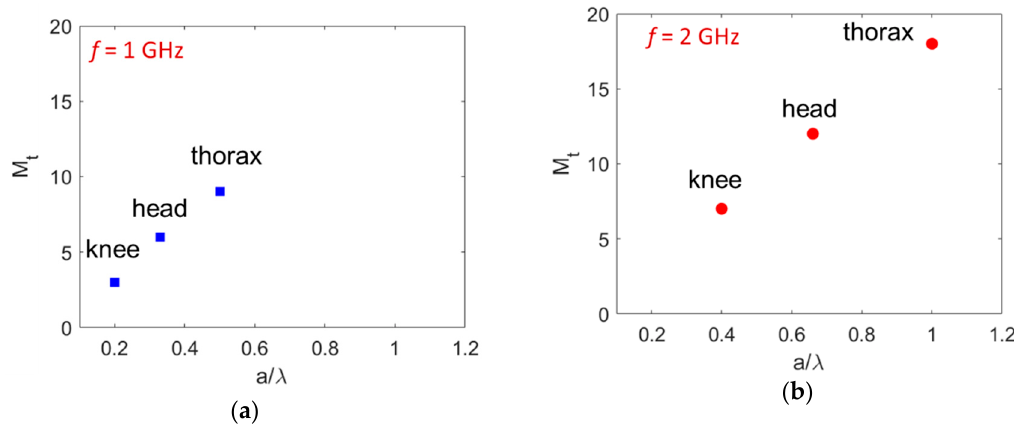
Figure 3. Truncation M t on the field expansions based on the target size 2 a (knee a = 6 cm, head a = 10 cm, thorax a = 15 cm) at two different frequencies: ( a ) 1 GHz; and ( b ) 2 GHz.